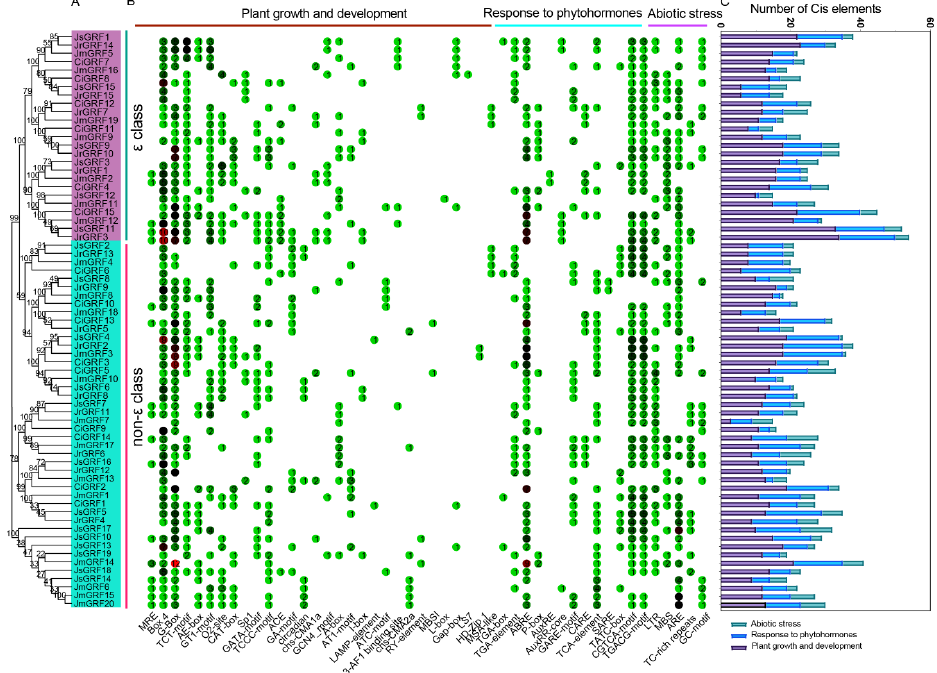
Figure 5. Phylogenetic relationship ( A ), distribution ( B ), and number ( C ) of cis-elements in the pro- moter region of GRFs of Juglandaceae. PlantCARE identified cis-acting elements using the 2000 bp upstream sequence of the Juglandaceae GRF gene.